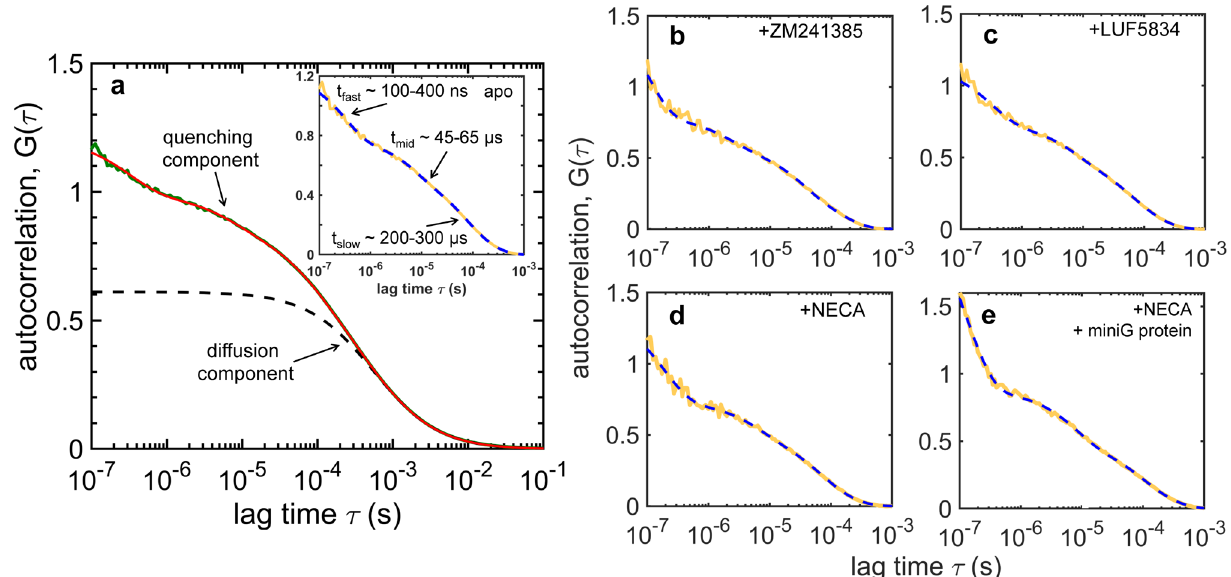
Figure 3. FCS measurements of conformational dynamics around residue 229 6.31 in A 2A R. ( a ) FCS data (green line) of A 2A R-V229C 6.31 -BODIPY-FL fitted to Eq. 5 (red line). The pure diffusion component in the fitted curve (black dashed line) can be subtracted from the data to highlight the decays due to excursions to the triplet state and to PET quenching. The inset shows the curves obtained after removing the diffusion term from the raw data (solid yellow) and the fitted curve (dashed blue). “Diffusion-free” FCS curves of the labelled receptor in the presence of ( b ) 100 μM ZM241385, ( c ) 100 μM LUF5834, ( d ) 100 μM NECA, and ( e ) 100 μM NECA, 2 mM MgCl 2 , 50 μM GDP and 10 μM mini G protein, respectively; raw data (solid yellow) and fitted curves to Eq. 5 (dashed blue). The fitting results for all sample conditions are summarized in Table